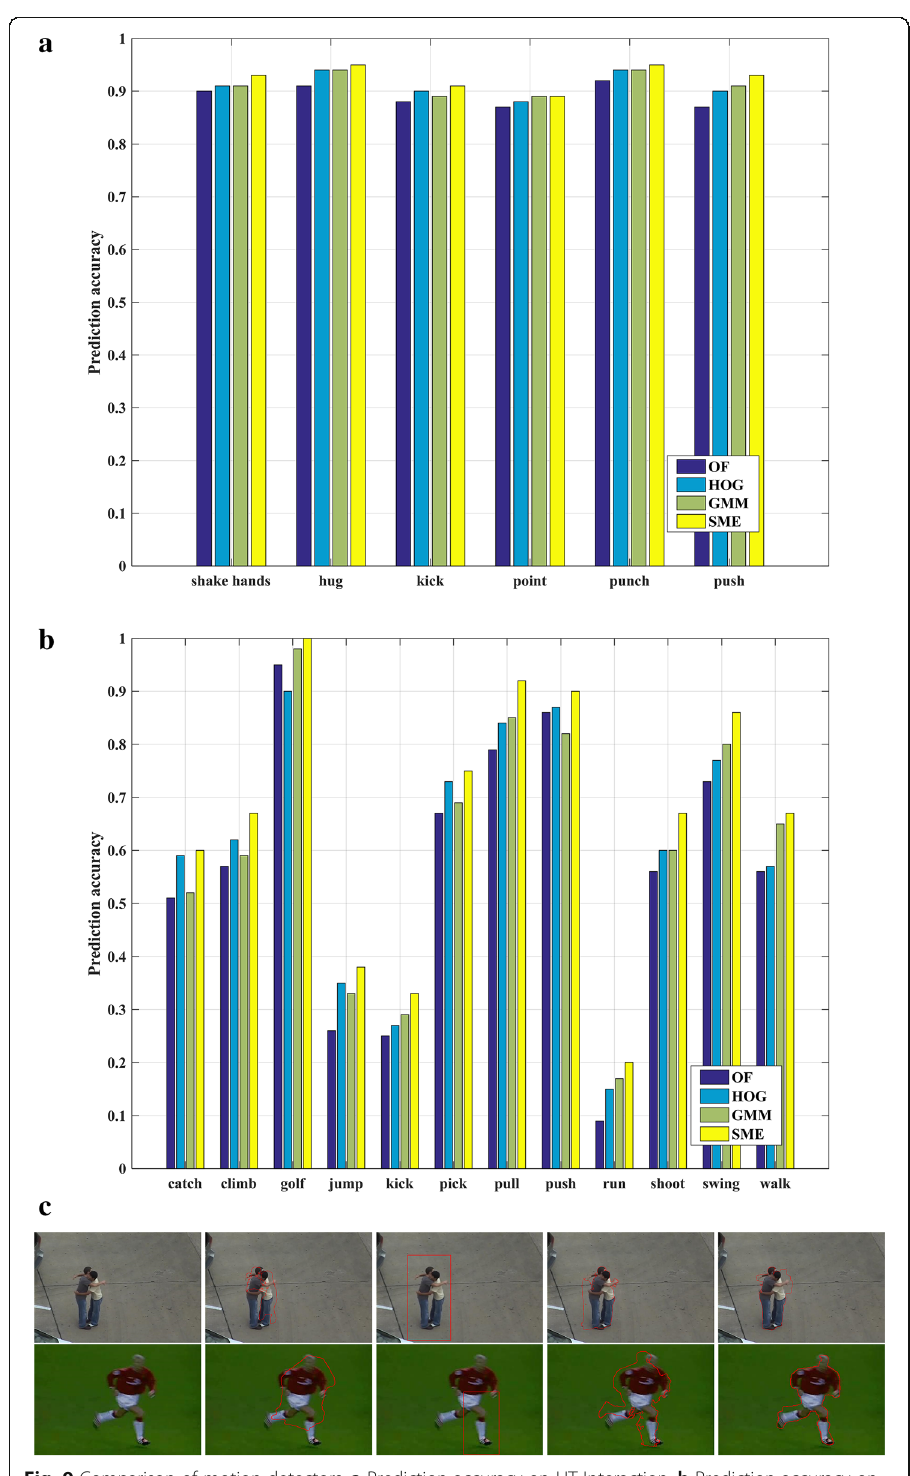
Fig. 9 Comparison of motion detectors. a Prediction accuracy on UT-Interaction. b Prediction accuracy on sub-JHMDB. c Example frames of different motion detectors. From left to right: original, optical flow, HOG human detector, GMM, and proposed